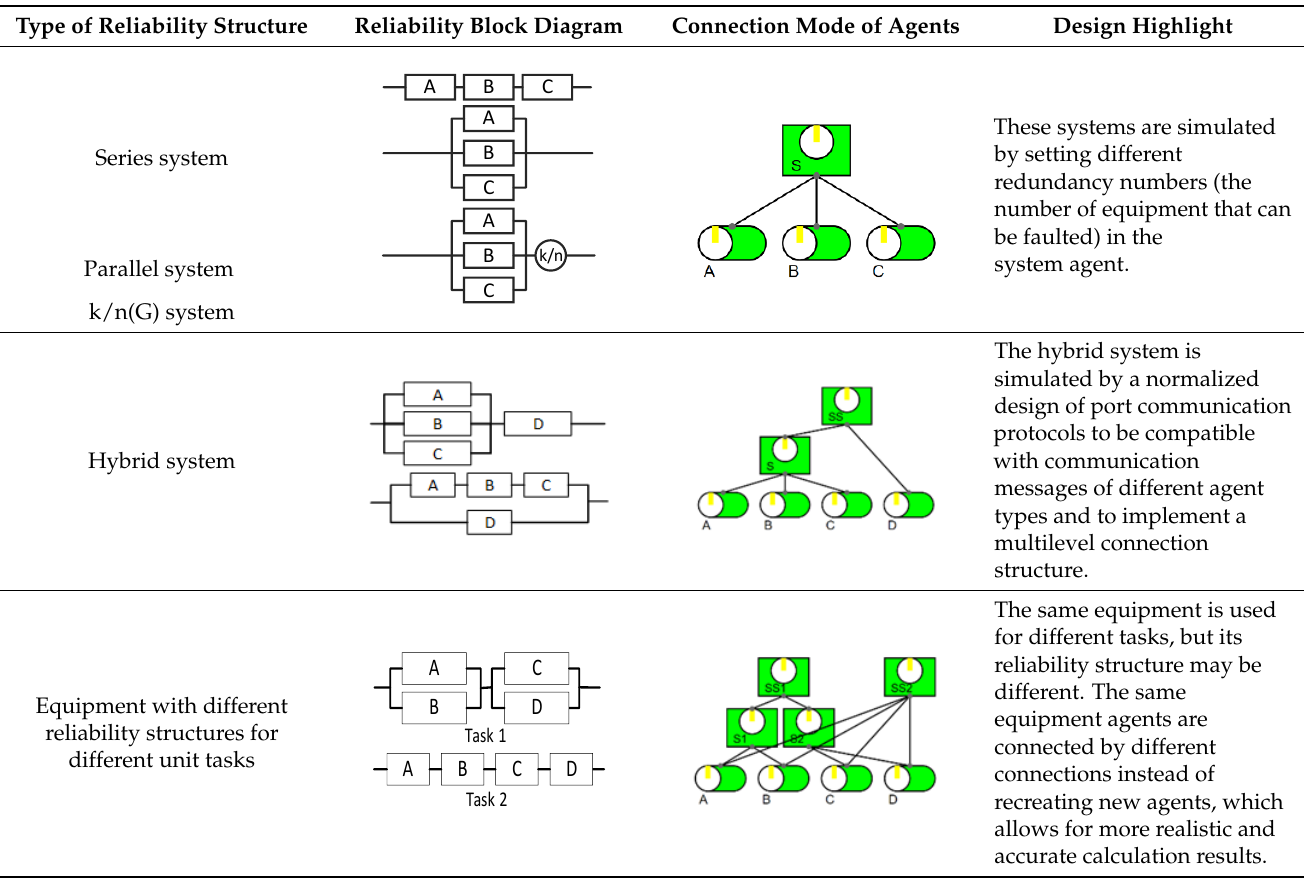
Table 3. Several types of equipment reliability structures.